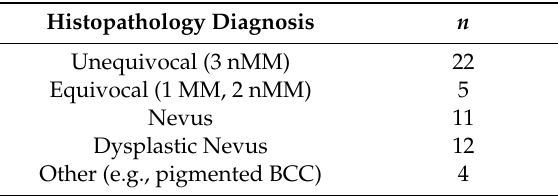
Table 2. Summary of false positive